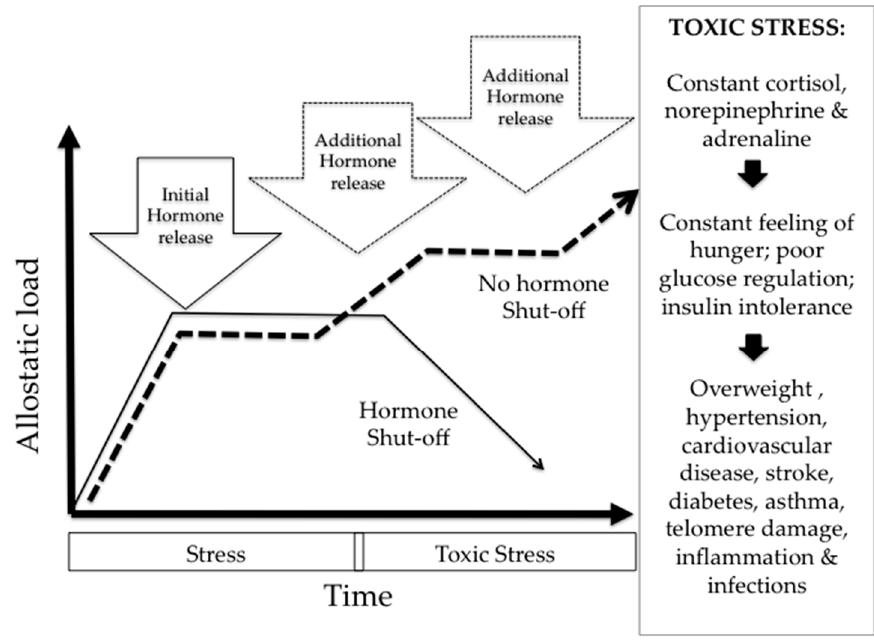
Figure 2. Toxic Stress and related health effects.